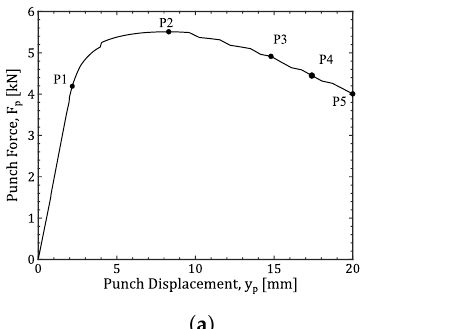
Figure 11. Implementation of material characterization problem: ( a ) punch force-displacement curve and the selected five pairs of values (P1–P5); ( b ) structure of the neural network with ten processing elements in the input layer corresponding to the five pairs of punch force-displacement values and two nodes in the output layer (Swift parameters — K and n ).